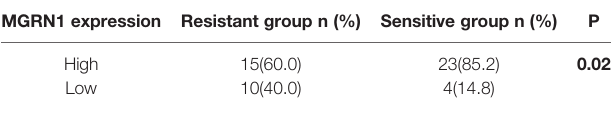
TABLE 2 | Comparison of MGRN1 protein expression between platinum- resistant HGSOC tissues and platinum-sensitive HGSOC